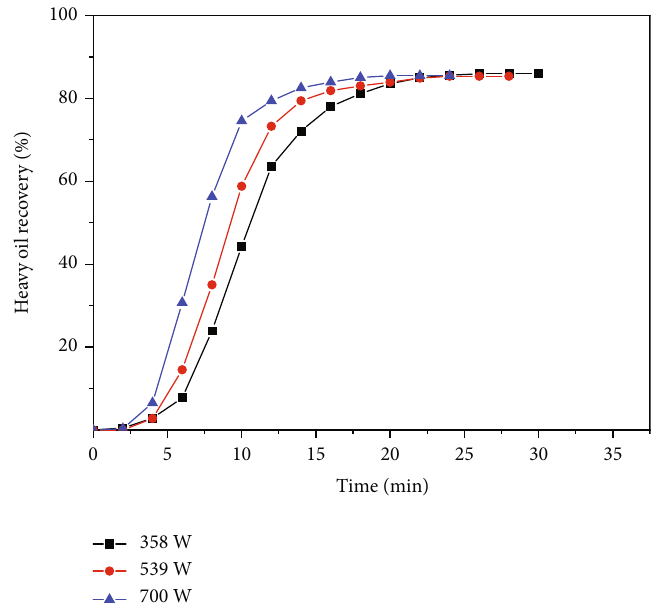
Figure 16: The experimental heavy oil recovery curves of each group under di ff erent microwave power.